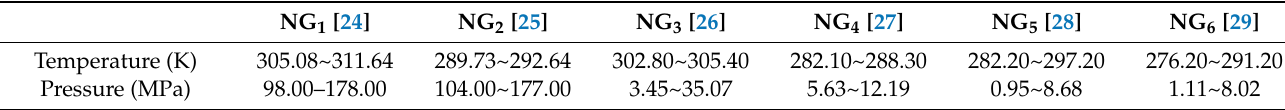
Table 4. Experimental range of gas hydrate formation